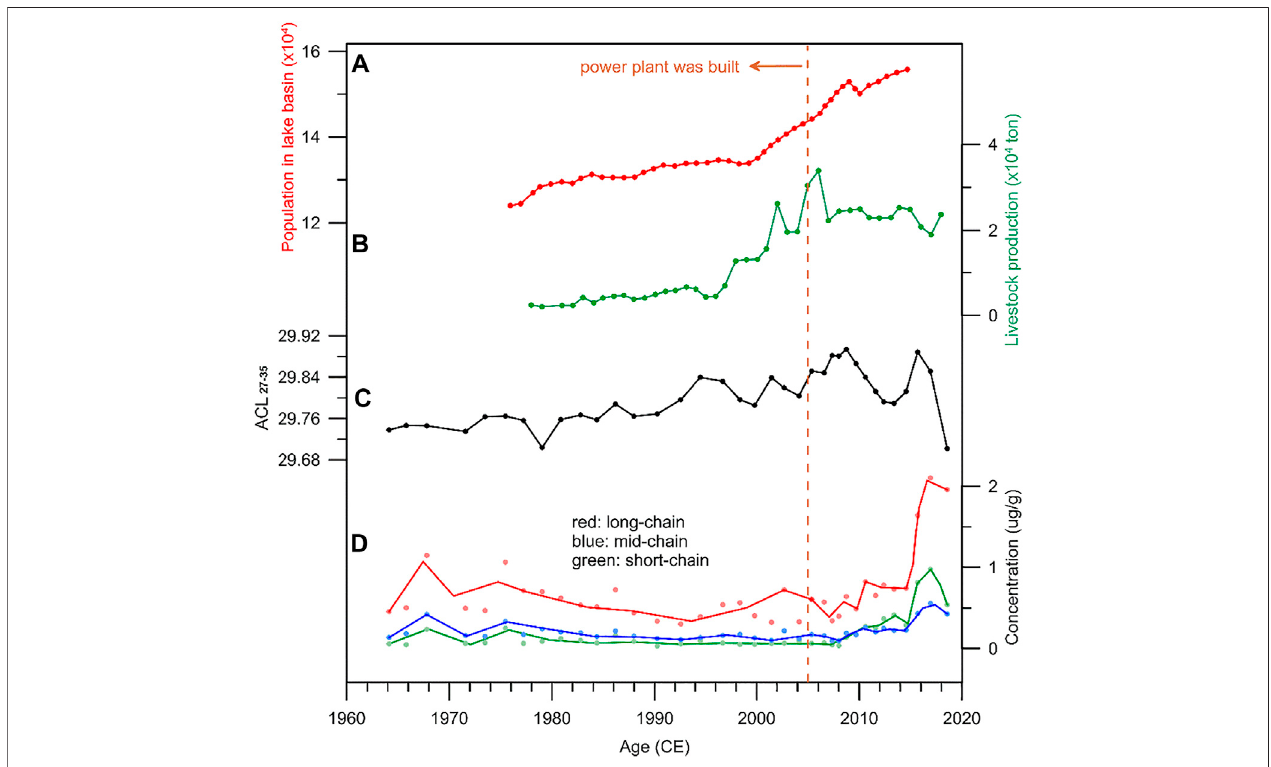
FIGURE7| Humanimpactson n -alkanesinDaihaiLakeoverthelast60 years. (A) PopulationintheDaihaiLakebasin(Liangetal.,2017). (B) Livestockproduction inLiangchengCounty(Sunetal.,2021). (C) ACL 27 – 35 recordofDH20B. (D) n -AlkaneconcentrationofDH20B:red,long-chain n -alkanes;blue,mid-chain n -alkanes;and green, short-chain n -alkanes. The curves were fi tted by spline smoothing (with fi ve points).